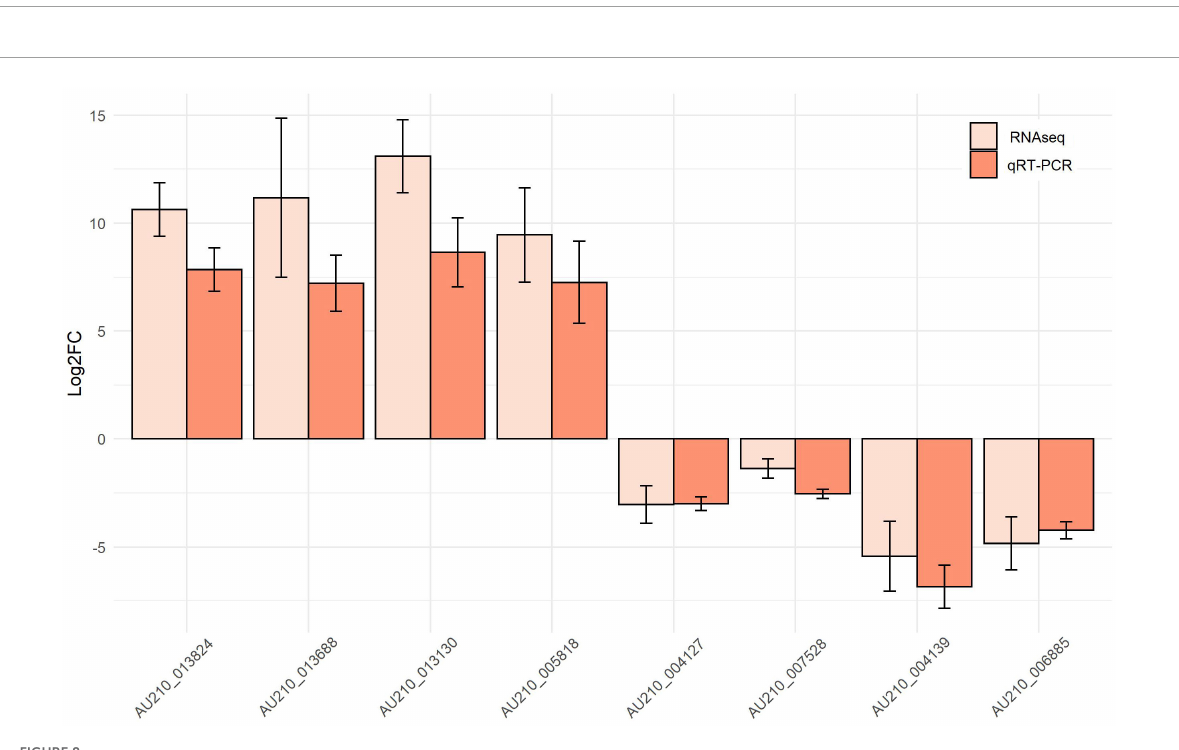
FIGURE8 Expression patterns of selected top hub genes from the turquoise and blue modules. The expression values for each gene were obtained from the meta-summary calculations and